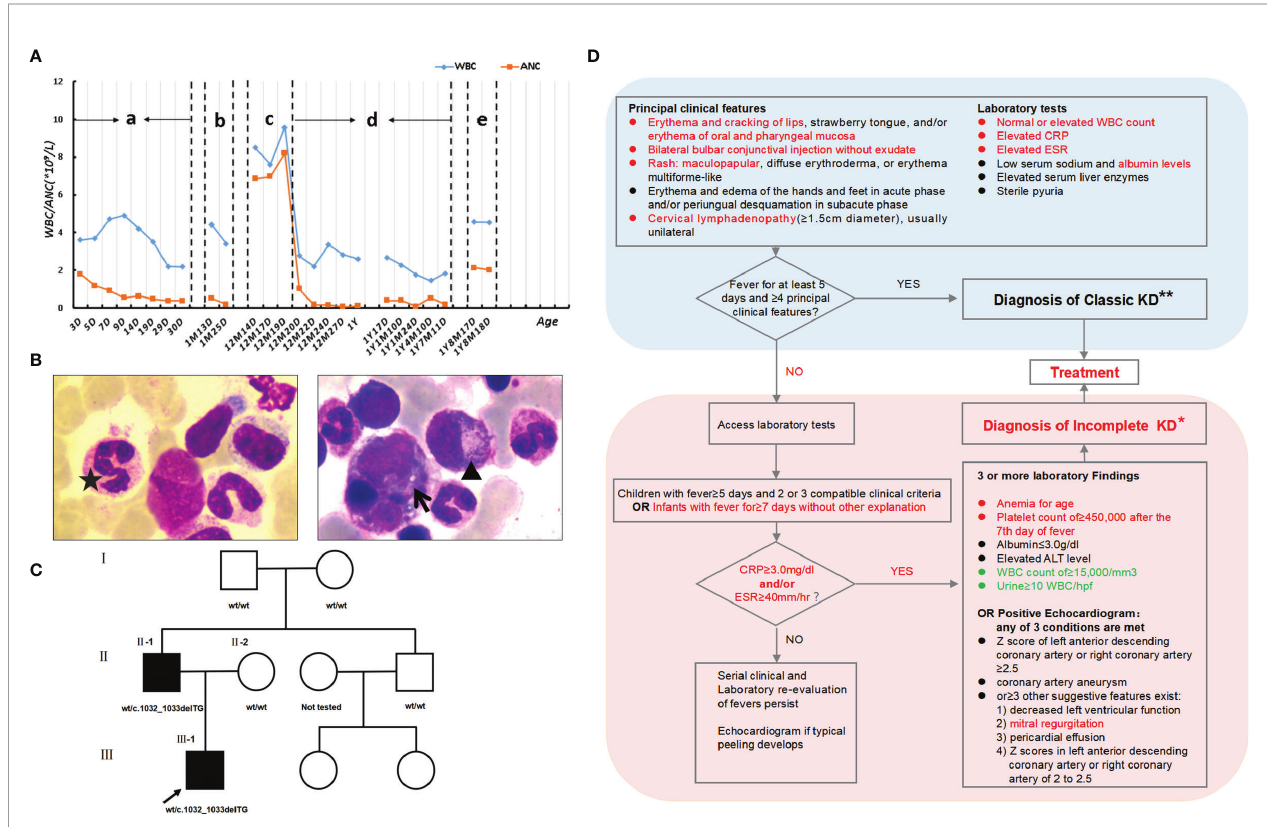
FIGURE 2 | Clinical data. (A) Levels of leukocytes and neutrophils of the patient since birth. “ a ” and “ d ” : normal stage; “ b ” , “ c ” and “ e ” : stage of infection or immune reaction. (B) A bone marrow (BM) smear stained with Wright-Giemsa (×1000) shows a hypercellular BM with mild granulocytic hyperplasia (myeloid: erythroid, 3.19:1) and plentiful granulocytic cells with right-shifted maturation, which is not consistent with peripheral neutropenia. Some neutrophils have coarse granules ( ▲ ), cytoplasmic vacuoles ( ↑ ), and multi-lobed nuclei ( ★ ). (C) Pedigree of the family. (D) Diagnosis of incomplete KD. Patient clinical features or laboratory tests highlighted in red showed the process of our clinical decision making. Due to WHIM syndrome, laboratory tests highlighted in green are controversial issues in the diagnosis of KD. ( * ) In the absence of a “ gold standard ” for diagnosis, this algorithm cannot be evidence based but rather represents the informed opinion of the expert committee. Consultation with an expert should be sought any time assistance is needed. ( ** ) Patients who lack full clinical features of classic KD are often evaluated for incomplete KD. If coronary artery abnormalities are detected, the diagnosis of KD is considered con fi rmed in most